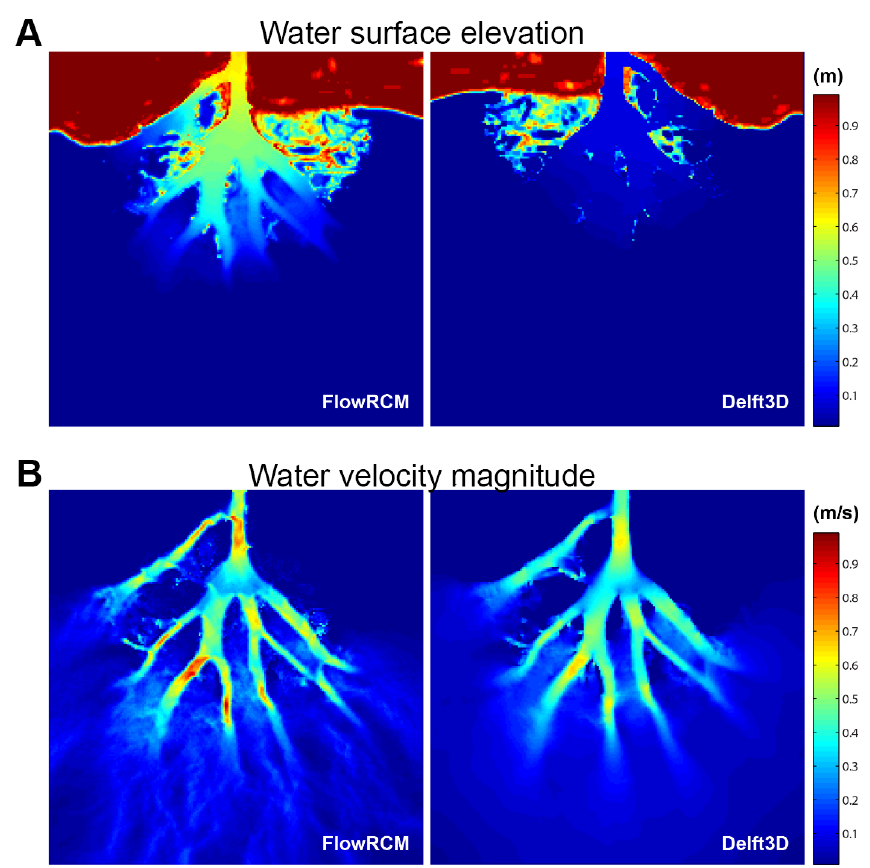
Figure 11. Results from test 4a (flow over synthetic bathymetry of WLD). (a) FlowRCM predicts a significantly higher gradient, while the water surface distribution is similar to the one predicted by Delft3D. (b) Velocity contour maps from model results; FlowRCM and Delft3D give similar flow distributions and predict “hot zones” where water velocity is significantly higher in channels.